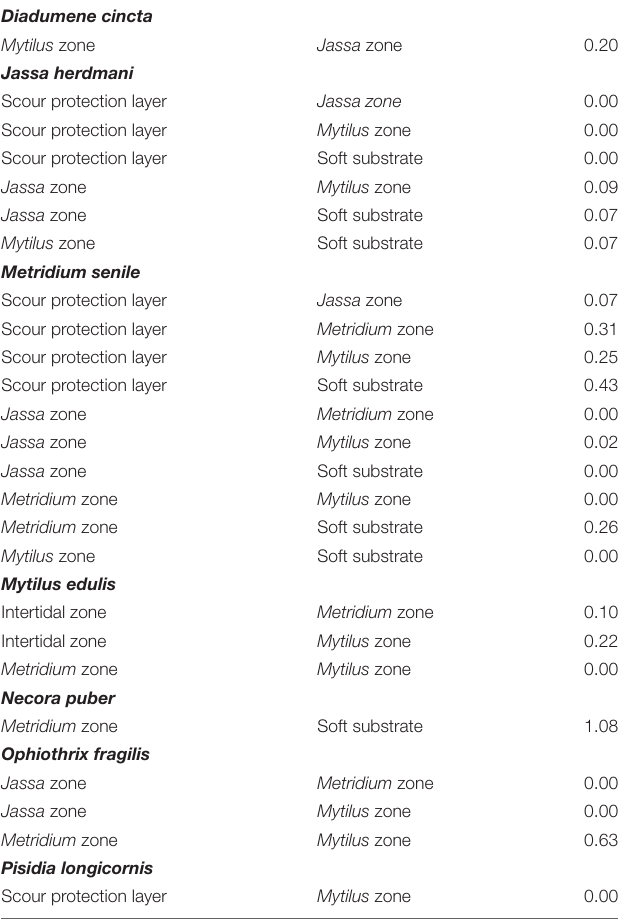
2 ) of the sample-size corrected standard ellipse areas (SEA C ) between the groups of the same species collected at different (cid:104)